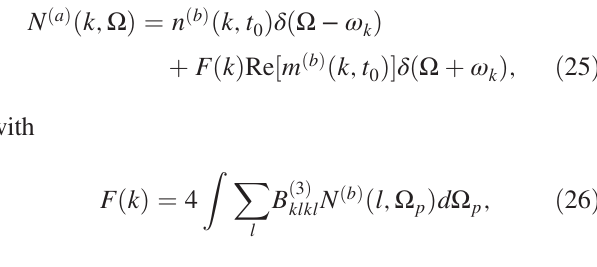
FIG. 5. Comparison of anomalous spectrum ω k jh m ð observed in numerical simulations (dots) with theoretical pre- dictions given by Eq. (24) (dashed lines) for ϵ ¼ 0 . 065 , 0.072, 0.086, and